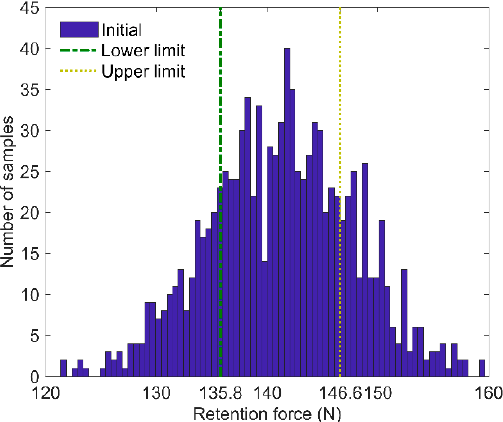
Figure 6. Initial output distribution.